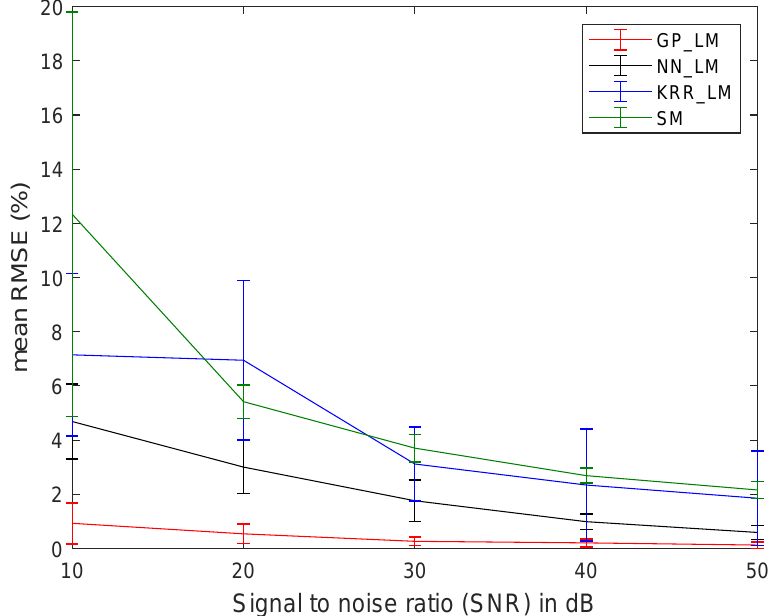
Figure 6. Root mean squared error (RMSE) (20 runs) for the methods using the proposed strategy (Gaussian processes (GP)_LM, kernel ridge regression (KRR)_LM, and neural networks (NN)_LM) and neural networks method with the softmax activation function in the last layer of the network (SM) as a function of signal-to-noise ratio (SNR).